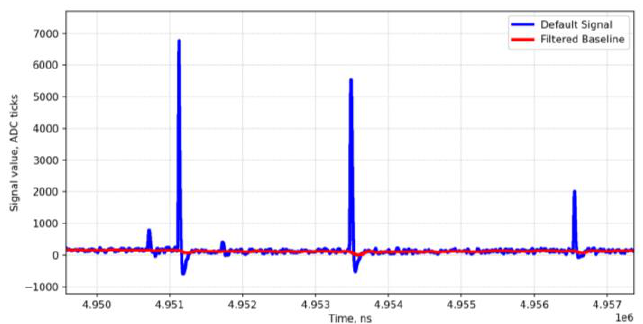
Fig. 7. Input signal (blue) and the calculated baseline